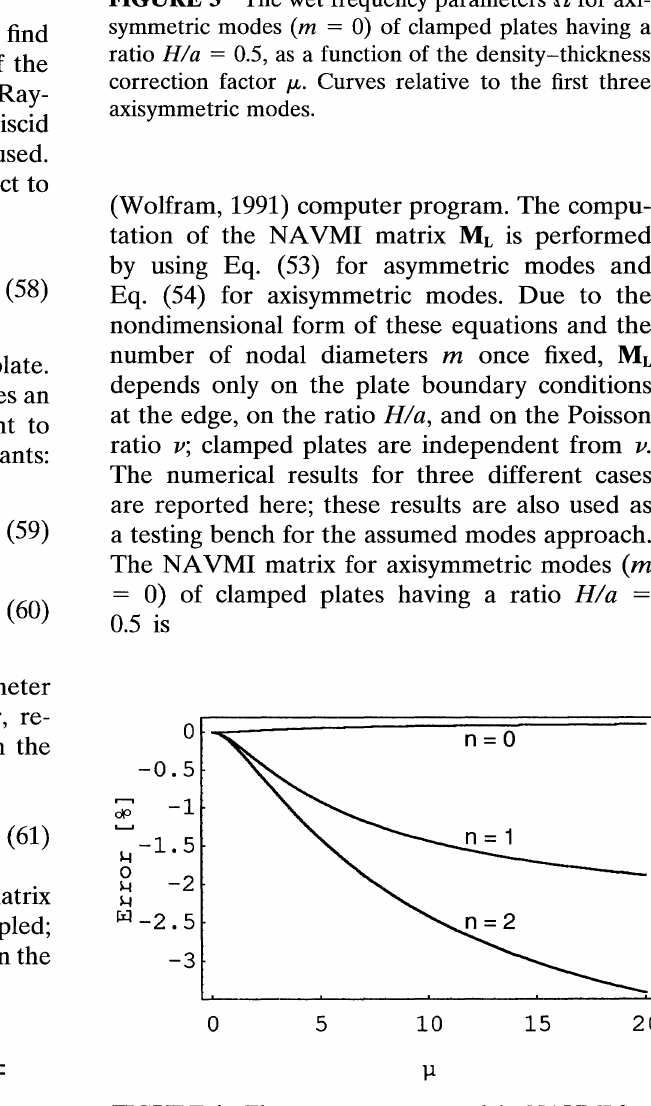
FIGURE 4 The percentage errors of the NA VMI fac tor solution in respect to the Rayleigh-Ritz results as a function of JL for clamped plates. Axisymmetric modes (m = 0) and H/a =